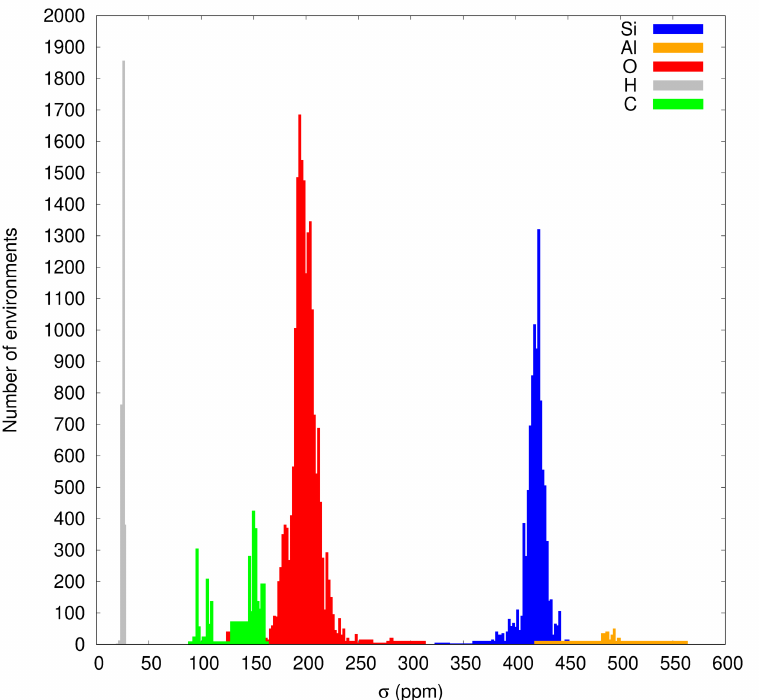
Figure 2. Distribution of the number of oxygen (O), silicon (Si), aluminium (Al), carbon (C), and hydrogen (H) atomic environments in zeolites, according to their isotropic shielding. The histograms are obtained with an interval of 2.0 ppm for C, O, Al, Si, and 1.0 ppm for H in the count of the number of atomic